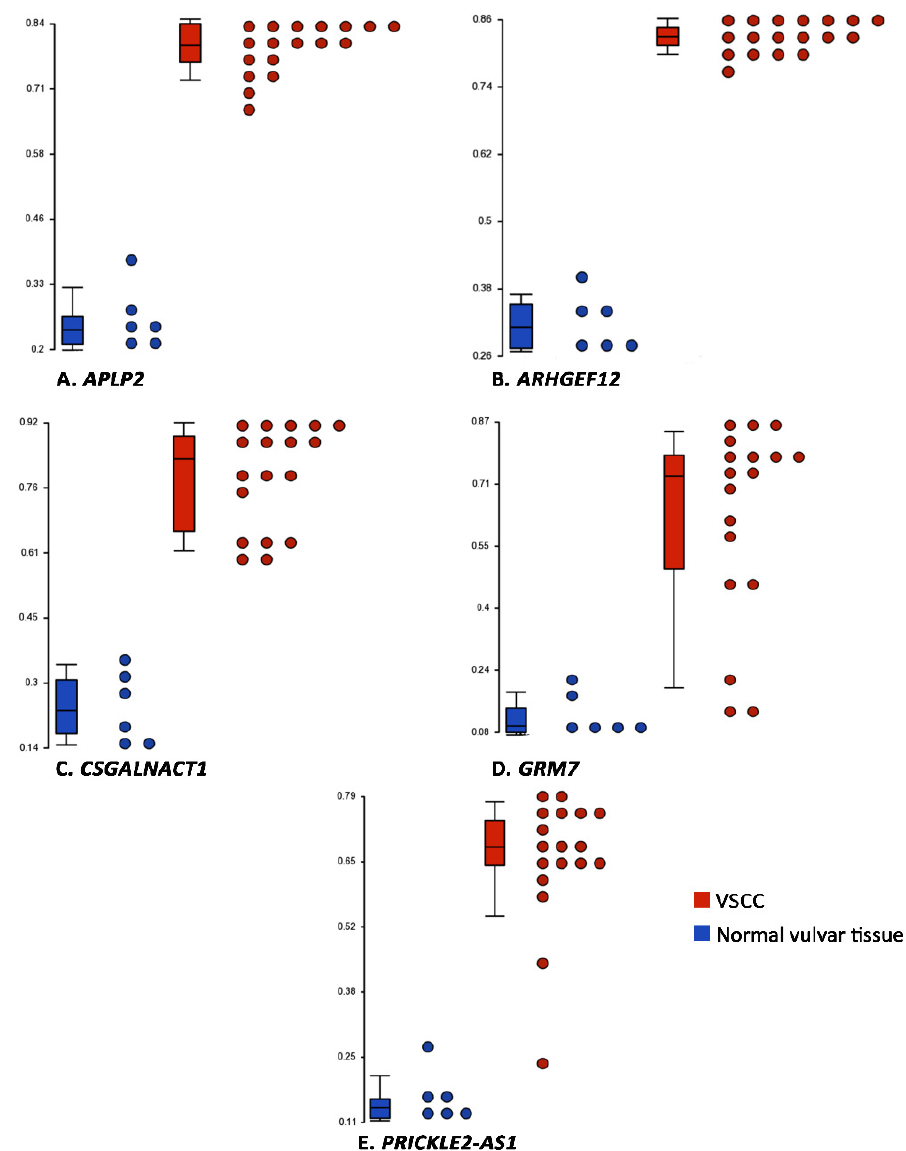
Figure 5. Box-plots depicting the range of β -values in normal vulvar tissues and VSCC, for the 5 genes that had a deletion in one allele and hyper-methylation in another allele. The y-axes indicate the β -values, horizontal lines in the boxes represent the medians, and the whiskers represent the 5th and 95th percentiles.